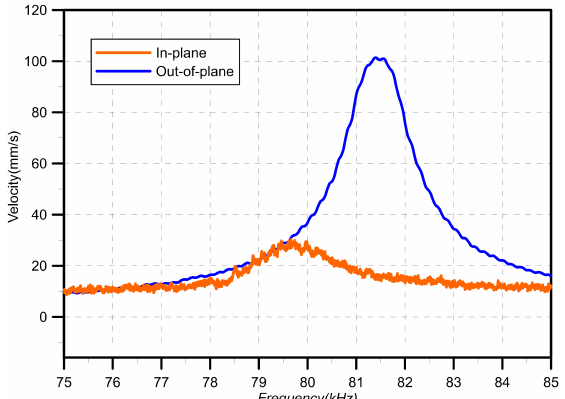
Figure 8. Out-of-plane and in-plane measurements of the frequency-response curves of the actuator under the excitation waveform V o = 7.5V as the frequency is swept from 75kHz to